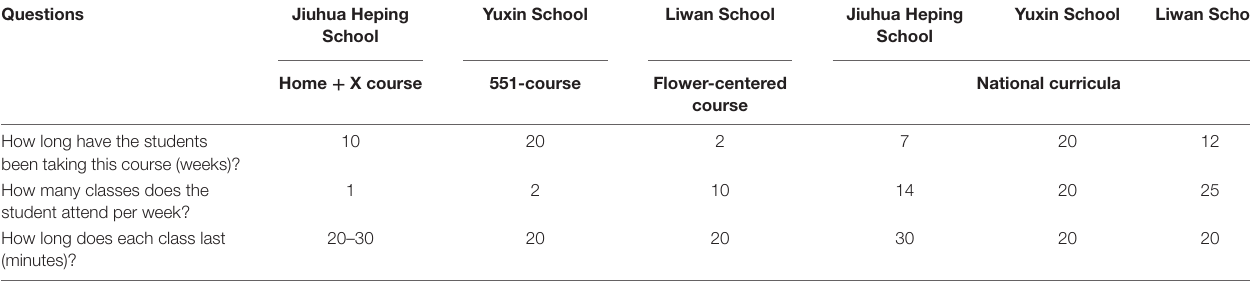
TABLE 3 | The class frequency and duration of the TBIT-based micro-courses and the national curricula by the time of data collection. Questions